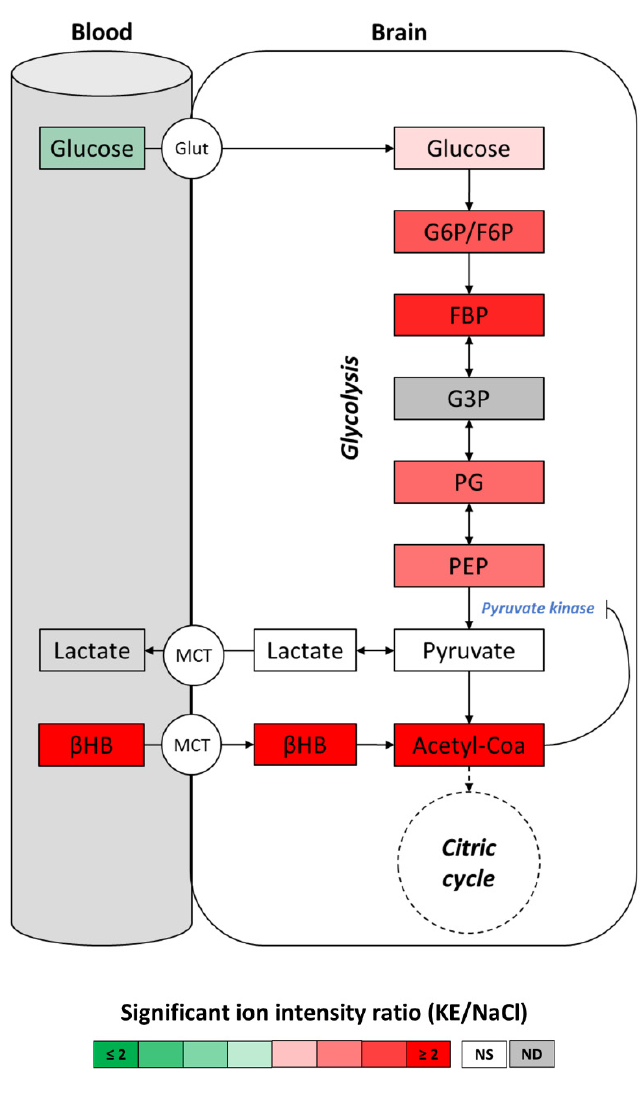
Figure 6. Brain metabolite levels of the glycolytic pathway after KE ingestion. Levels of brain glycolytic intermediates were assessed by LC-MS 30 min after the ingestion of KE (3 mg KE/g of body weight) or 0.9% NaCl. Plasma glucose and β HB levels were measured using an enzymatic assay shortly before cerebral dislocation ( n = 10). ND: not detected; NS: not significant. (MCT: monocarboxylate transporters; Glut: glucose transporters; G6P: glucose-6-phosphate; F6P: fructose-6-phosphate; FBP: fructose-1,6-biphosphate; G3P: glyceraldehyde-3-phosphate; PG: phosphoglycerate; PEP: phosphoenolpyruvate).